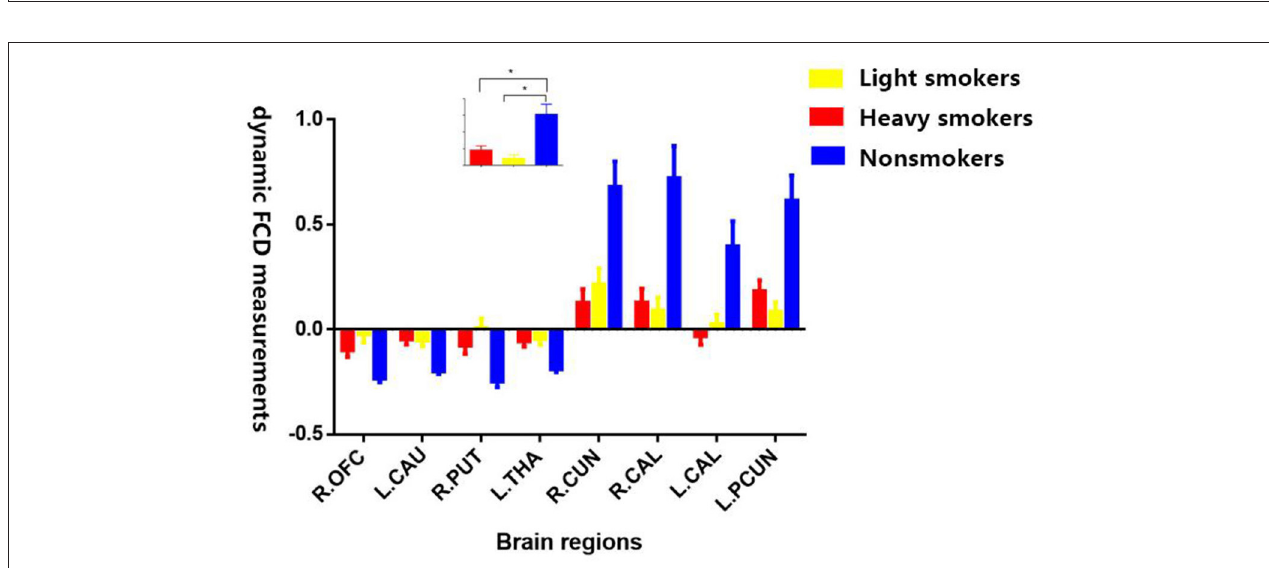
FIGURE 2 | Shared alternations of dFCD measurements of brain regions in both heavy smokers and light smokers compared with nonsmokers. R.OFC, right orbitofrontal cortex; L.CAU, left caudate; R.PUT, right putamen; L.THA, left thalamus; R.CUN, right cuneus; R.CAL, right calcarine; L.CAL, left calcarine; L.PCUN, left precuneus. (The subplot means that both heavy and light smokers have significant alternations of dFCD measurements compared with nonsmokers). * means difference between the two groups has statistical significance. in the right thalamus was positively correlated with FTND ( r = 0.265, p = 0.003, Bonferroni